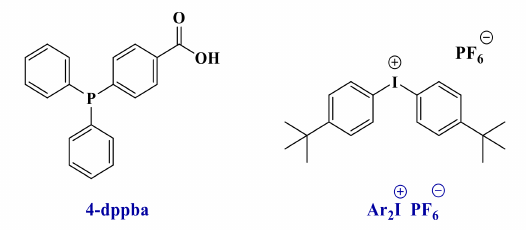
Scheme 4. Chemical structures of the two